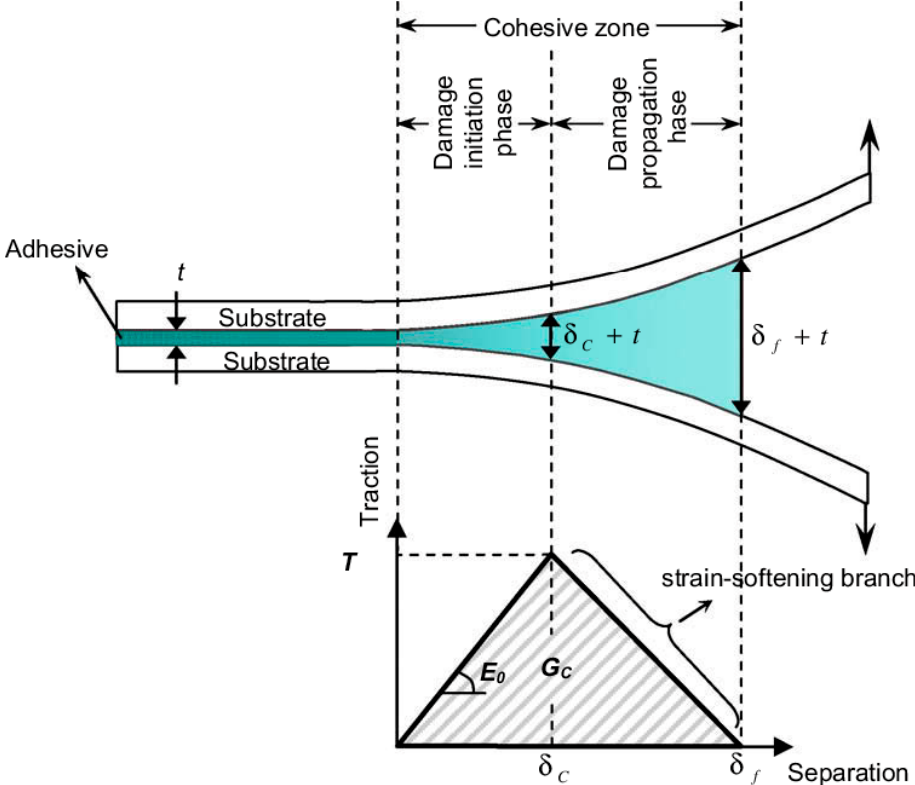
Figure 12. Schematic damage process zone and corresponding bi-linear traction–separation law in an adhesively bonded joint. Reproduced with permission [67].